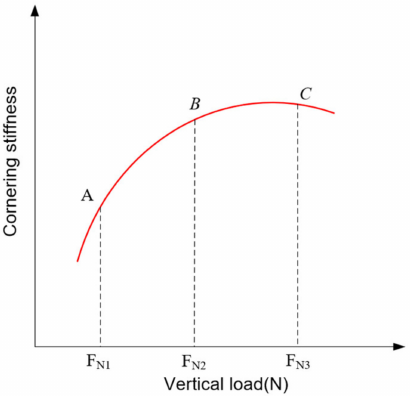
Figure 4. The influence of vertical load on tire cornering